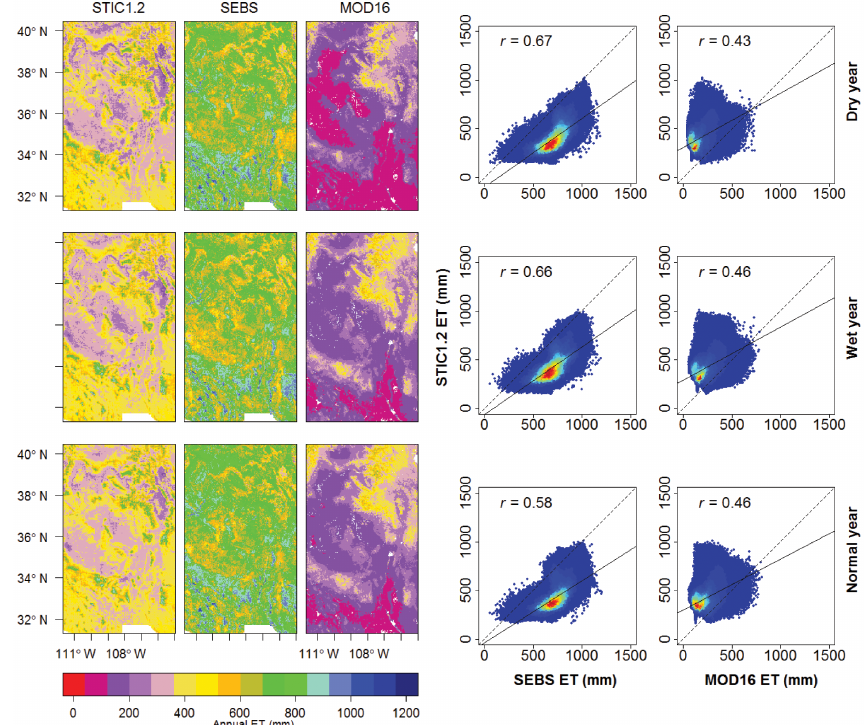
Figure 9. Annual ET (mm) maps for the dry, wet, and normal years derived from STIC1.2, SEBS, and MOD16 for the Midwest2 (MW2) bounding box covering US-ARM, US-SRG, US-Wkg, and US-NR1 flux sites (Fig. 1). Scatter plots between annual ET estimates from STIC1.2 vs. SEBS and MOD16 are shown on the right.